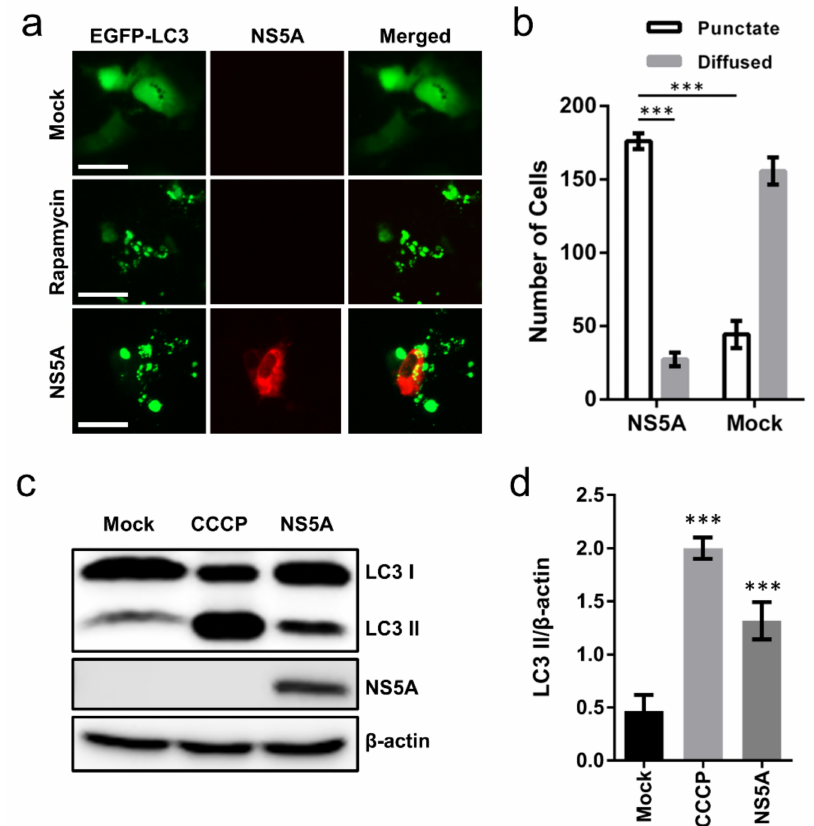
Figure 1. Transient transfection of NS5A increases punctate formation. ( a ) Huh-7.5 cells were co-transfected with EGFP-LC3 and NS5A or EGFP-LC3 only (mock) for 48 h after which the cells were immunostained with anti-NS5A antibody (9E10) and examined for punctate formation. Rapamycin = 100 nM; magnification = 200 × ; scale bar = 50 µ m. ( b ) Quantification of punctate and diffused cells from a. A total of 200 cells were randomly counted and the numbers of punctate and diffused cells were determined in NS5A-transfected cells and the mock transfection control group. ( c ) Huh-7.5 cells were transfected with NS5A in 6-well plates and examined for LC3 lipidation 48 h post-transfection by extracting cell lysate for Western blotting analysis. ( d ) Densitometry of ( c ). Results are from 3 independent repeats with errors bars indicating mean ± standard deviation (SD); representative micrographs and Western blots are shown. β -actin served as a loading control for all analyses. Asterisks (*) denote statistical significance for the indicated parameters analyzed ( b ) or compared with mock ( d ): *** p <